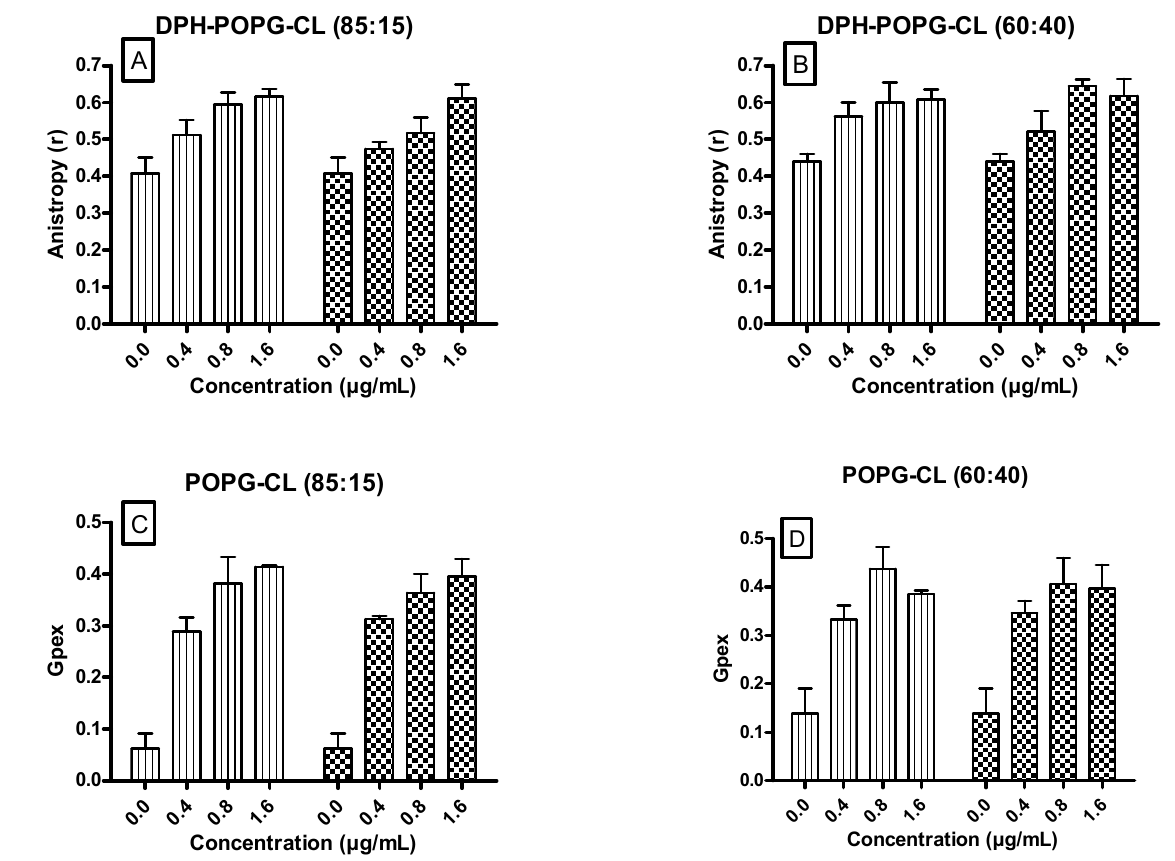
Figure 4. Effect of UA (Ursolic acid) (vertical lines) and OA (Oleanolic acid) (lattice) on fluorescence anisotropy (r) of DPH (Diphenylhexatriene) ( A , B ) and on generalized polarization (Gpex) values for Laurdan ( C , D ) in lipid vesicles (POPG:CL, 85:15 ( left ) or POPG:CL, 60:40 ( right )). Data (SEM) are representative of experiments that were reproduced three times. No significant differences were observed when UA and OA were compared. POPG (1-Palmitoyl-2-oleoyl- sn -glycero-3- phosphoglycerol), CL (cardiolipin).